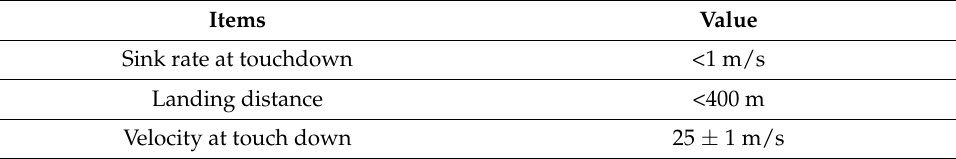
Table 3. Target performance.